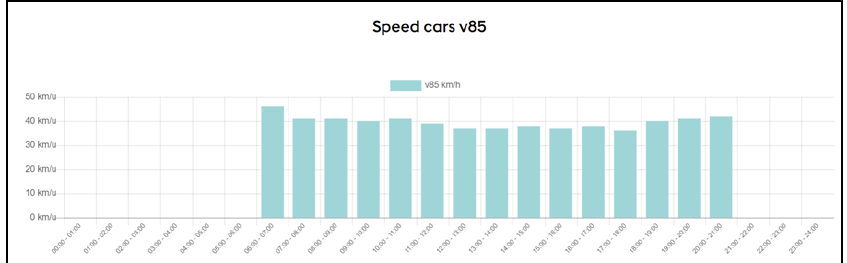
Figure 10. Average speed limit (V85) per hour in the period from 22 August until 22 September recorded by the sensor close to Sensor 4 in Differdange.